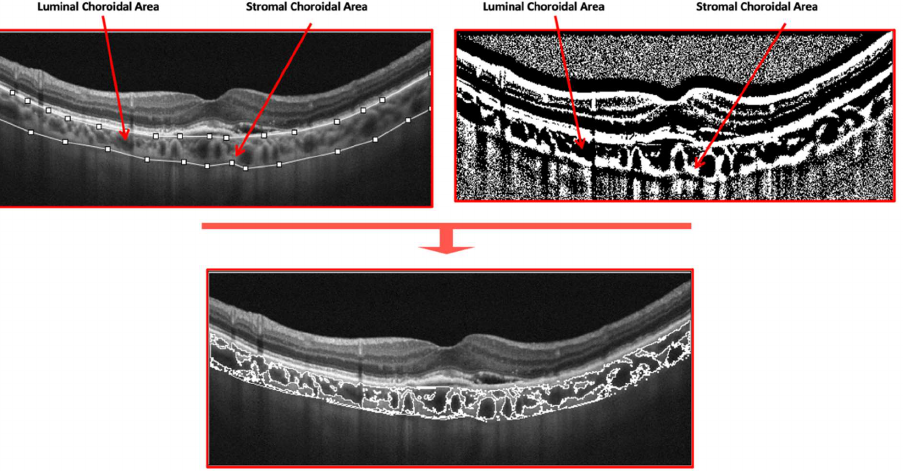
Figure 1. Illustration of the method used to analyze choroidal vasculature from spectral-domain OCT images of an eye with neovascular